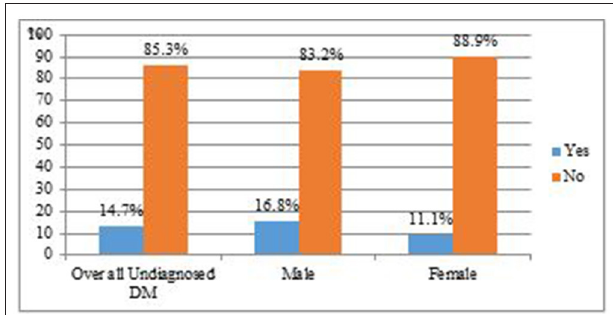
FIGURE 1 | Prevalence of Diabetic Mellitus among Menja Community, South-west, Ethiopia, 2021 ( N = 415).